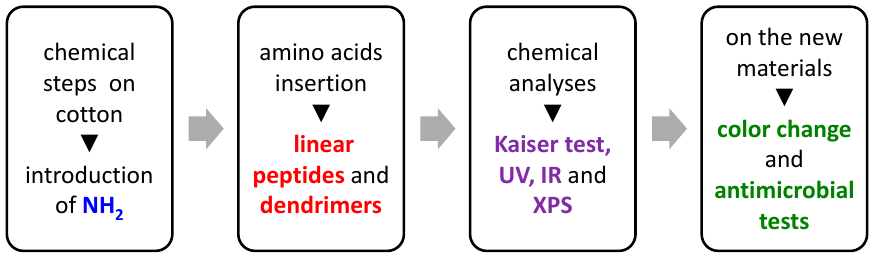
Figure 1 . Flowchart summarizing the steps performed on the cotton surface. Figure 1. Flowchart summarizing the steps performed on the cotton